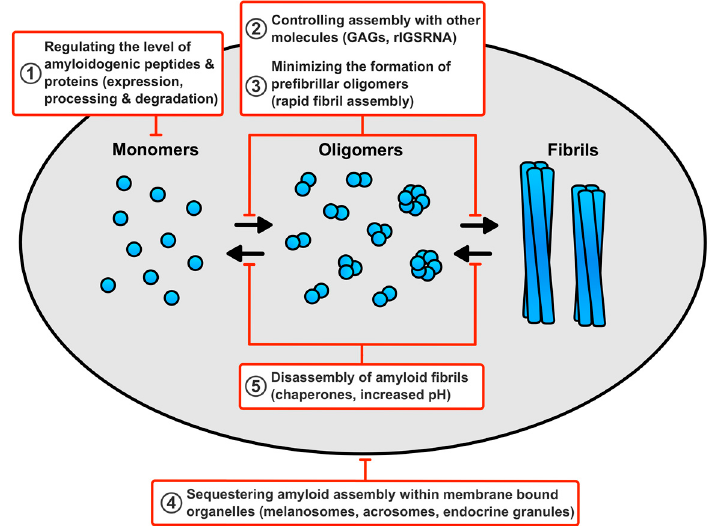
Figure 2. How human cells prevent functional amyloids from causing toxicity? (1) Controlling the level of the amyloidogenic peptides and proteins by regulating its expression, degradation, and generation by proteolysis of a protein precursor will prevent the overproduction of amyloids. (2) The rapid assembly of fibrils will reduce the production of any potentially toxic prefibrillar oligomers. (3) Molecules, such as glycosaminoglycans (GAGs) and ribosomal intergenic noncoding RNA (rIGSRNA), promote amyloid assembly ensuring it only occurs when and where required. These molecules may also promote rapid fibril assembly and prevent unwanted interactions with other cellular components. (4) Sequestering assembly and storage of amyloids within membrane bound organelles will prevent unwanted interactions with other cellular components. (5) The ability to disassemble functional amyloids, under physiological conditions, with chaperones or by exposure to higher pH, will ensure that the fibrils can be removed when no longer required.